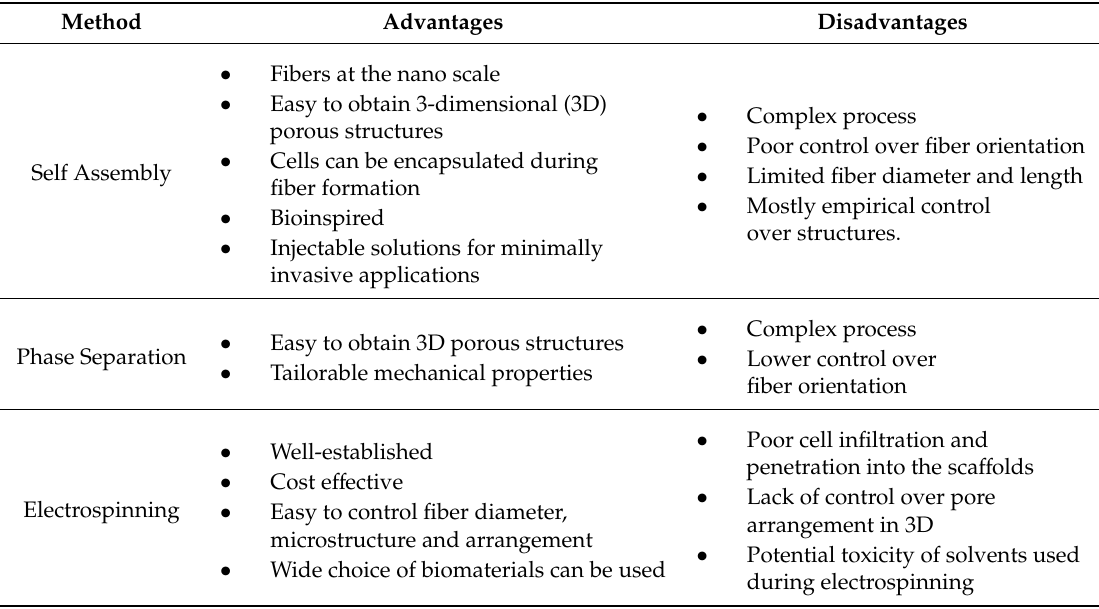
Table 1. Comparison of three di ff erent nanofiber fabrication